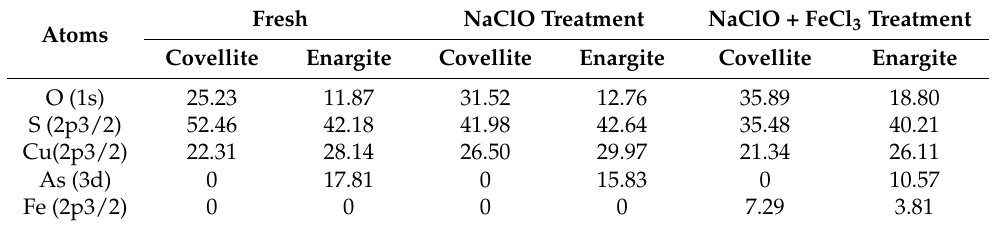
Table 1. Atomic concentrations (at%) of the covellite and enargite surfaces with different depressants. Fresh NaClO Treatment NaClO + FeCl 3 Treatment Atoms Covellite Enargite Covellite Enargite